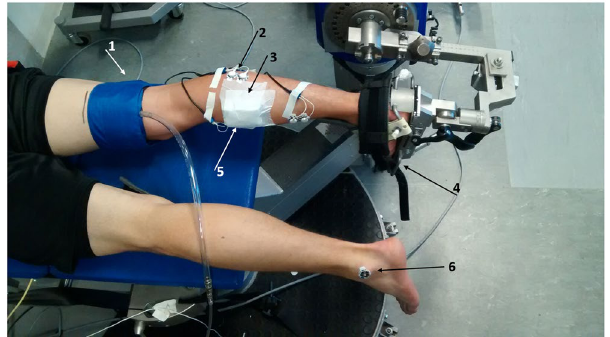
Figure 2. Experimental Setup. 1: Pressure Cuff. 2: EMG Electrodes. 3: Near-infrared spectroscopy device. 4: Footrest including safety belts and binding system. 5: Position of gastrocnemius medialis electrodes. 6: Reference